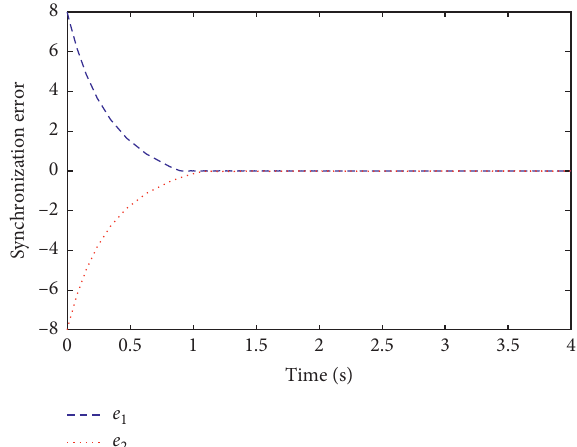
Figure 5: Fixed-time stability based on the controller (50).